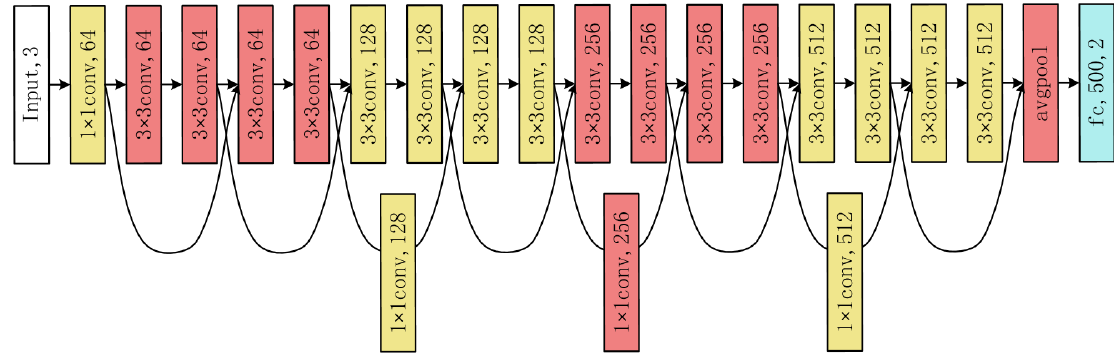
Figure 4. Network structure diagram of ResNet18.